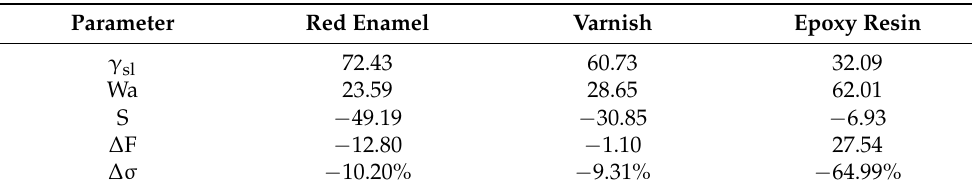
Table 7. Wetting parameters (mJ/m 2 ) calculated for red enamel, insulating varnish, and epoxy resin, as well as the conductivity decrease that the BP-coating system experienced. Parameter Red Enamel